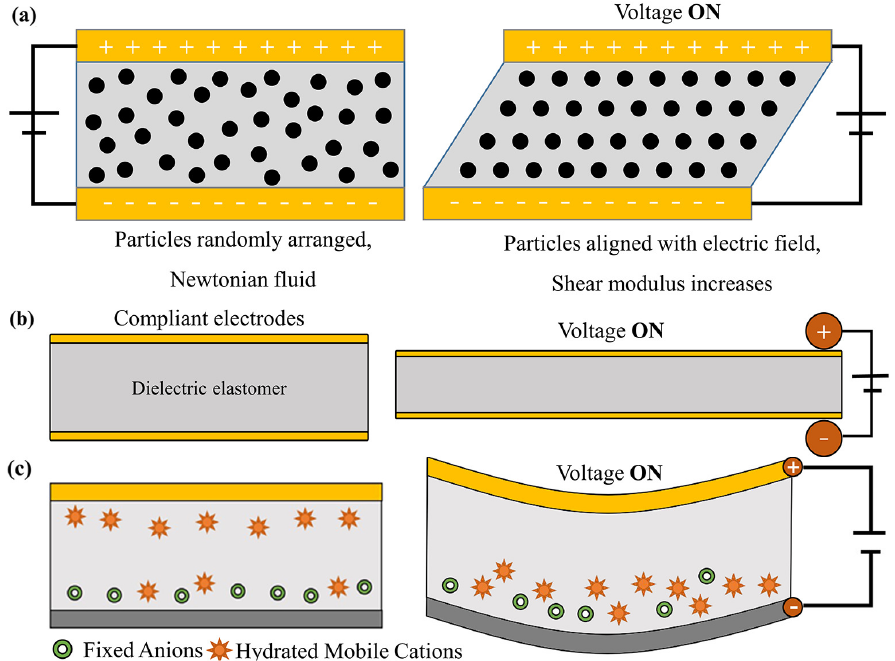
Figure 3. ( a ) Internal dielectric particle transformation of ERF after applying electric field. ( b ) De- formation schematic diagram of DE under voltage. ( c ) Deformation schematic diagram of IPMC under